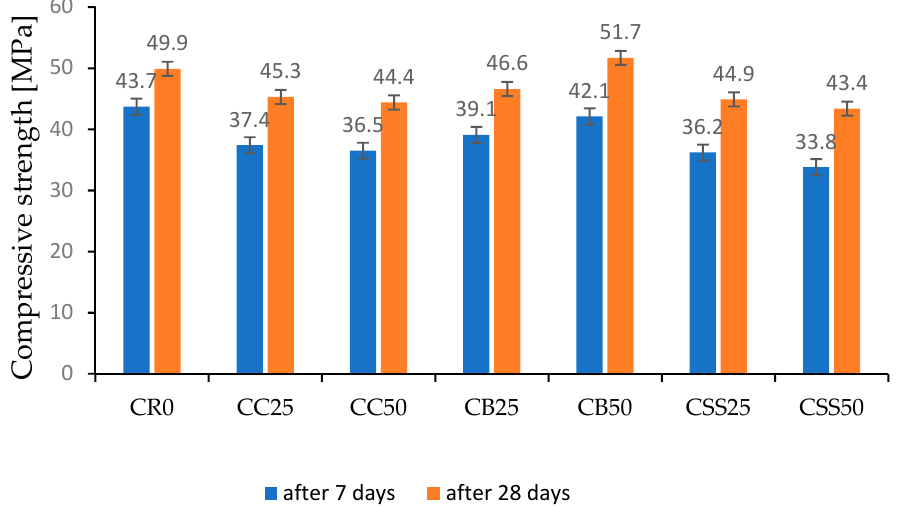
Figure 9. The test results of concrete compressive strength.